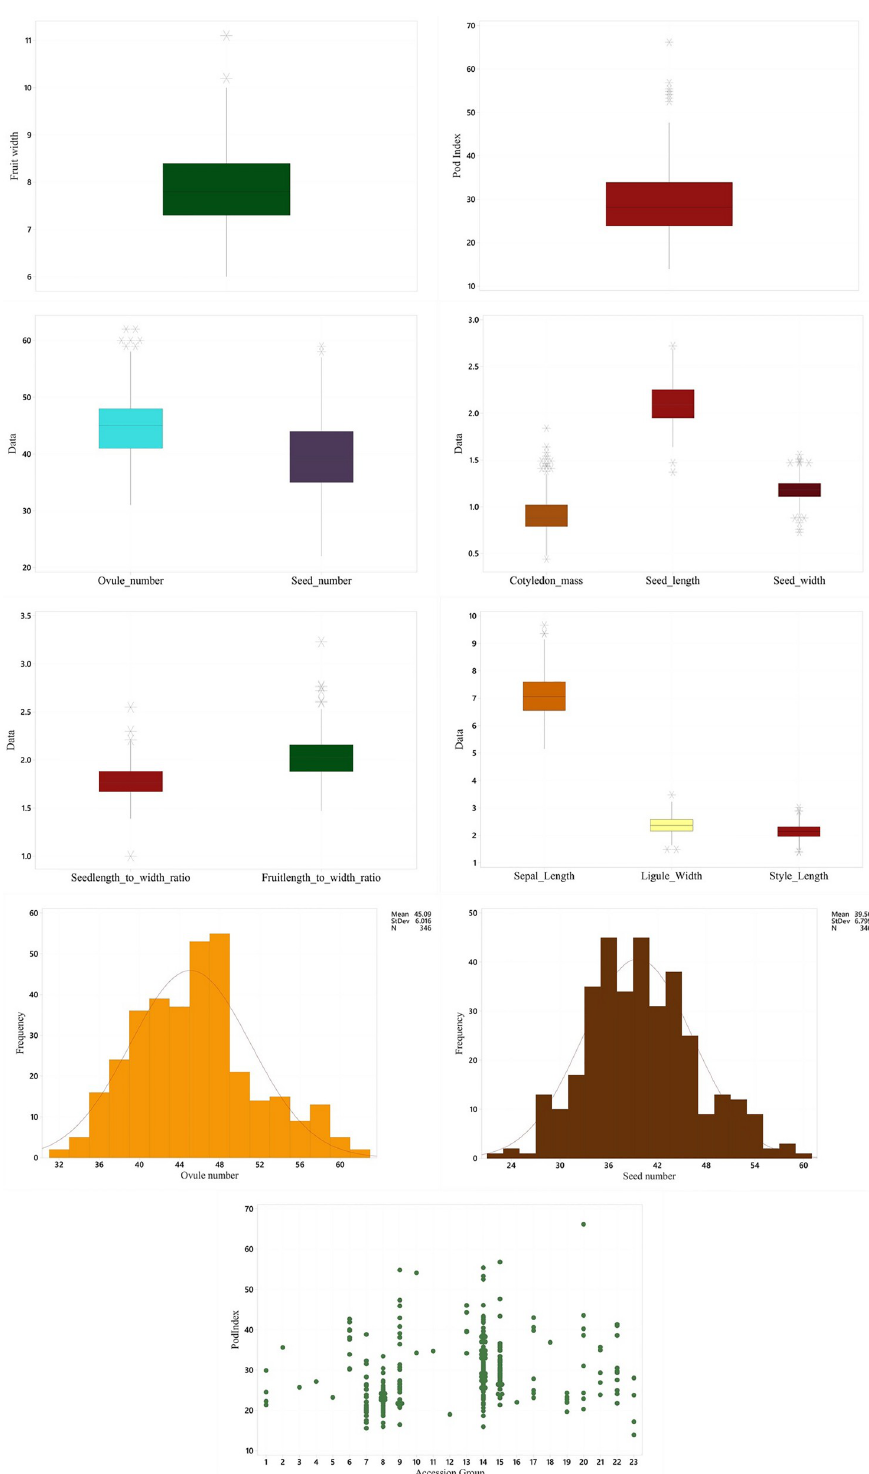
Fig 1. Box and whisker plots, histograms and individual value plot for pod index showing variation in the yield- related traits. The asterisks in the box and whisker plots represent outliers.